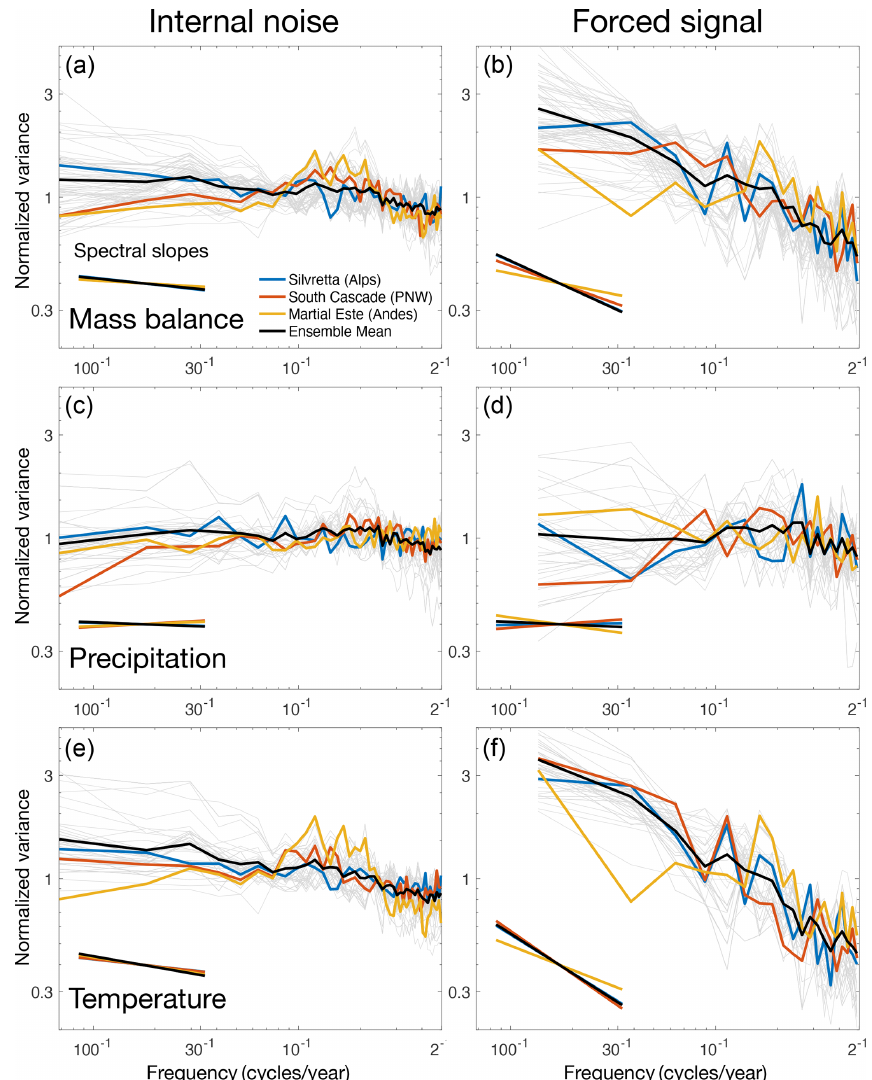
Figure 4. Power spectra of forced and unforced variability for the pre-industrial era (1000 to 1880). Internal (unforced) variability is shown in the left column (a, c, e) and forced variability in the right column (b, d, f) . Top row (a, b) is annual mass balance, middle row (c, d) is winter precipitation, and bottom row (e, f) is summer temperature. Spectra are shown for Silvretta (blue), South Cascade (red), Martial Este (yellow), and the other 73 glaciers (gray). The black line shows the average of all 76 individual spectra. Lines in the bottom left of each panel show the slope of the least-squares regression line for each spectrum. Spectra were computed using periodograms with a Hanning window equal to one-third the length of the data. Unforced spectra were averaged among the 13 ensemble members. Forced spectra were band-averaged to reduce noise, explaining the coarser spectral